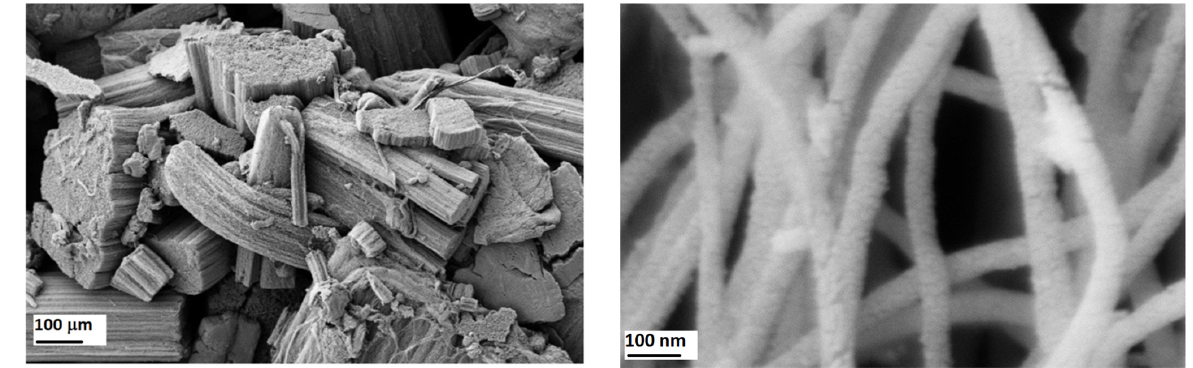
Figure 9. SEM image of MWCNT/Cu ( left ); high resolution SEM image ( right ). The sensing properties of the MWCNTs/Cu and f-MWCNTs/Cu structures obtained by the physical method were comparatively analyzed (Figure 10). It was established that the sensitivity significantly increases after functionalization of MWCNTs by oxygen-containing groups.